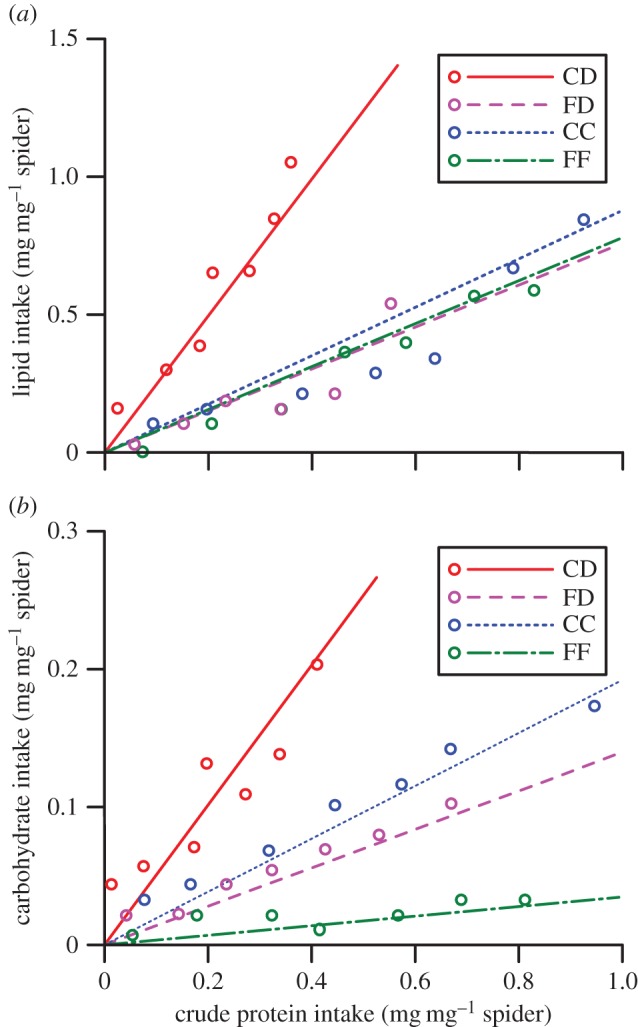
Nutritional rails show the ratio of (a) protein : lipid and (b) protein : carbohydrates extracted by Nephila pilipes fed live crickets (CC), live flies (FF), dead crickets with the web stimulated by live flies (CD) or dead flies with the web stimulated by live crickets (FD) over seven rounds of feeding. Points represent mean values for each round of feeding (1–7).